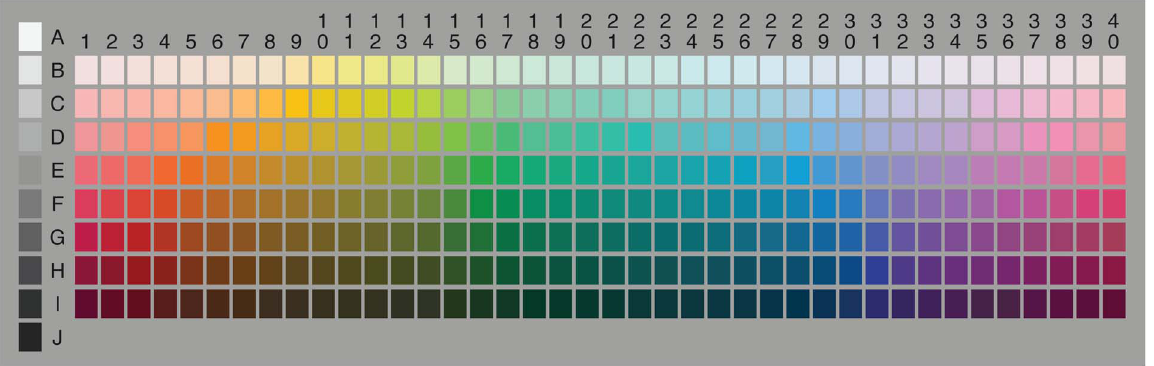
Figure 1. The Munsell color chart as used by the World Color Survey. All color distribution figures in this paper use this chart as a reference map; with darker grays for higher distribution intensity values and lighter grays for